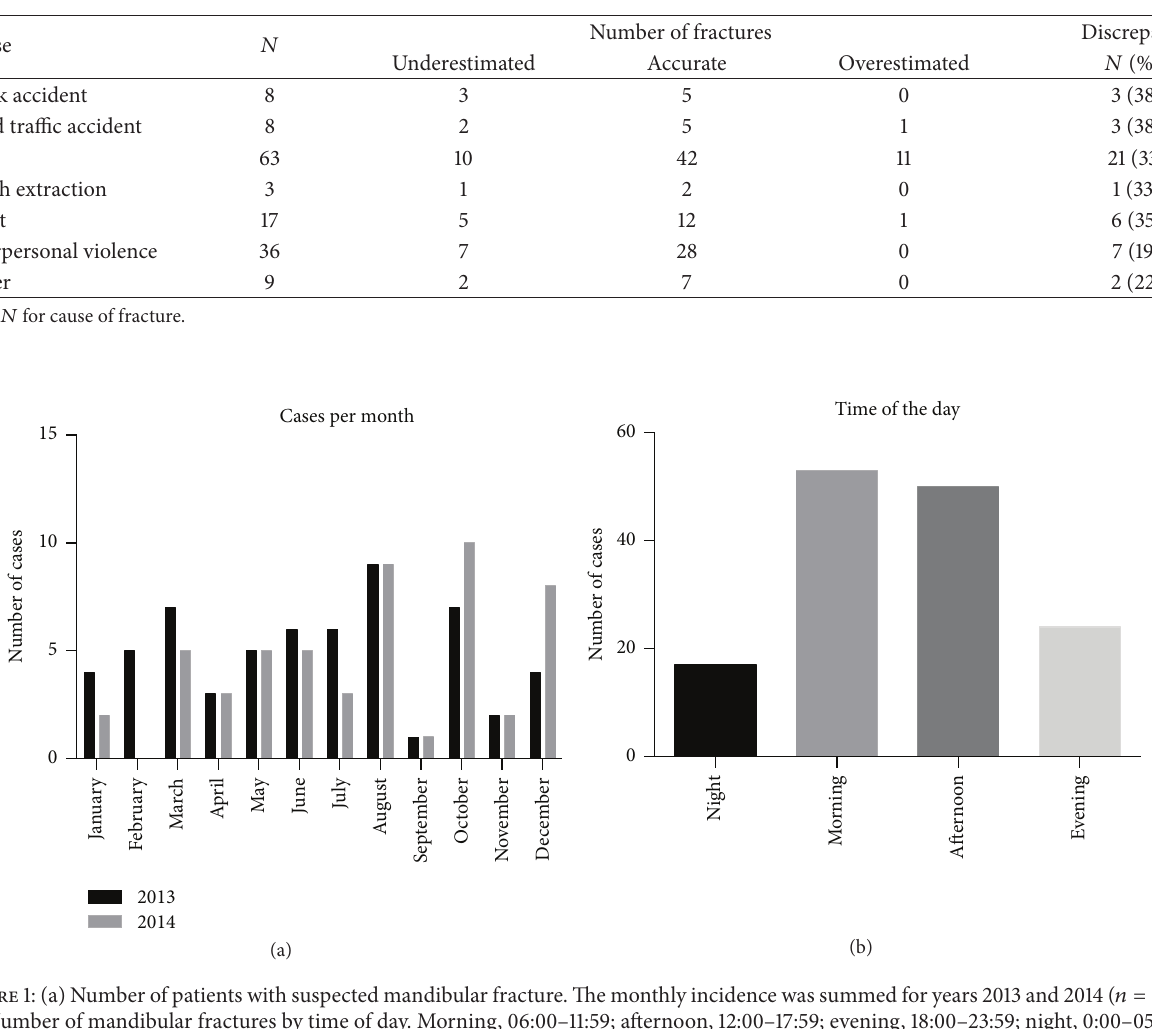
Table 4: Underestimates and overestimates of number of fractures per patient by cause ( 𝑁 = 144 ).